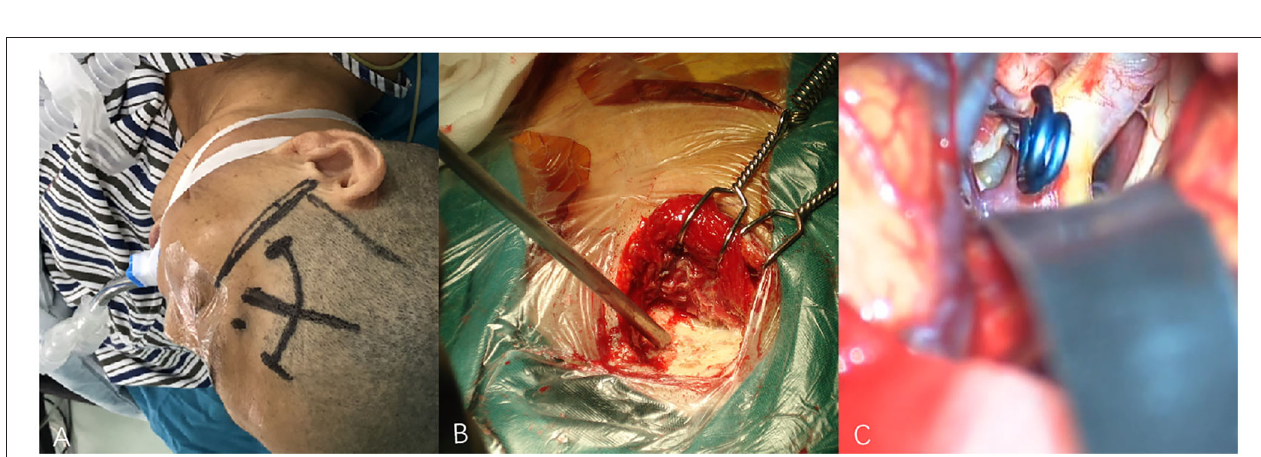
FIGURE 3 | (A–C) Techniques during pterional keyhole approach (PKA) surgery in a patient with middle cerebral aneurysm (MCA). (A) The cutting edge of upper edge of pterion. (B) The bone window of PKA. (C) The aneurysm was clipped under microscope.